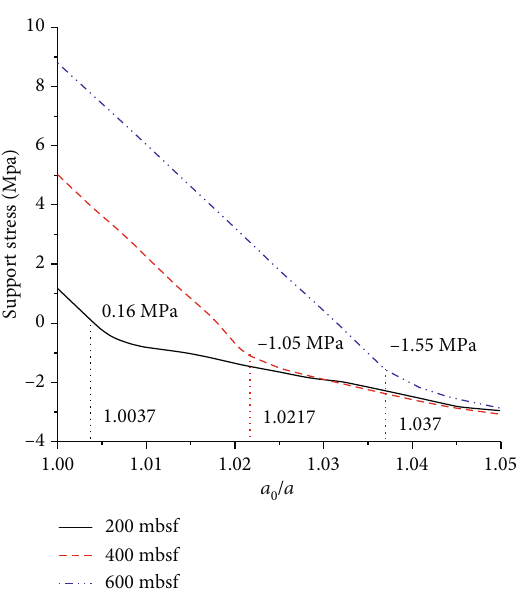
Figure 6: Relationship between borehole support stress and a di ff erent depths.